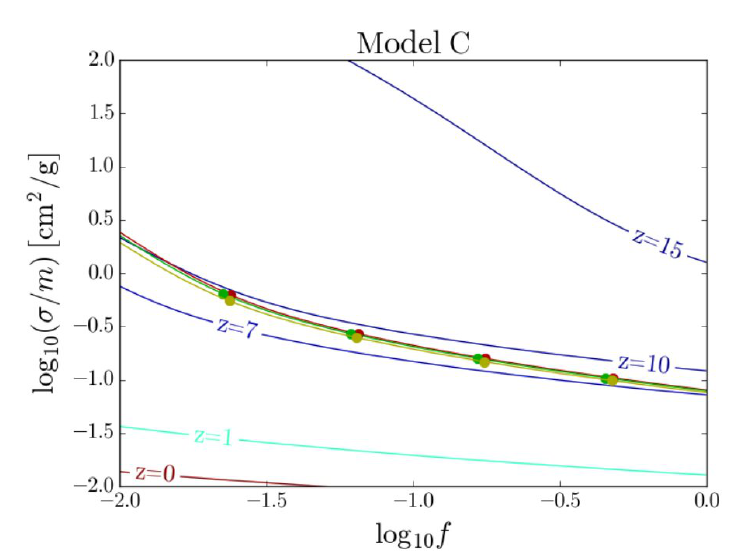
Figure 8: Trajectories in the plane of σ/ m versus fraction of atomic DM f , with scat- tering assumed to be dissipative, showing the degeneracy of DM parameters with the amount of accretion subsequent to BH formation, for models consistent with redshifts of three observed SMBHs (taken from Ref. [ 56 ] ). Successive clusters represents steps of 1 e -folding in mass growth, from right to left, and contours of constant redshift z are shown. The BHs corresponding to the rightmost cluster must have undergone 1 or 2 e -foldings of growth to match the